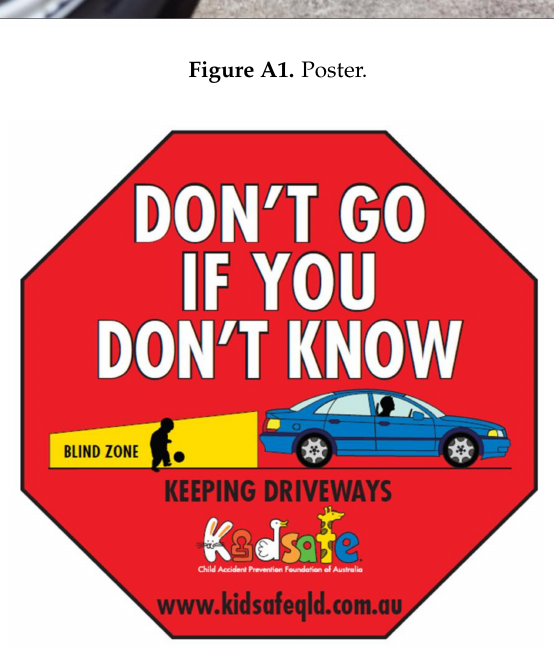
Figure A1. Poster.